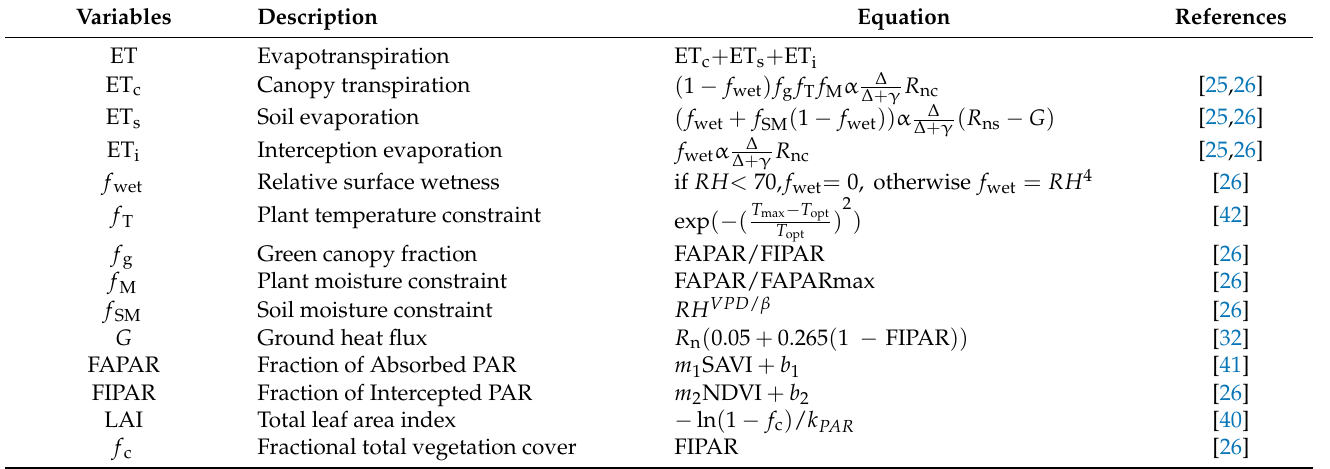
Table 1. Summary of parameters and equations for the PT-JPL model. R n is the net radiation, R nc is net radiation to the canopy ( R n − R ns ), R ns is net radiation to the soil ( R n exp( − k R n LAI)), RH is relative humidity (%), T max is maximum air temperature, T opt is optimum plant growth temperature, and the default value of T opt is 25 ◦ C [2], VPD is saturation vapor pressure deficit, FAPAR max is the maximum value of FAPAR in a year, k Rn is extinction coefficient (k Rn = 0.60) [39], k PAR = 0.5 [40], β = 1.0 kPa, m 1 = 1.2 × 1.136, b 1 = 1.2 × ( − 0.04) [41], m 2 = 1.0, b 2 = − 0.05 [26], SAVI is soil adjusted vegetation index (NDVI × 0.45 + 0.132) [28].